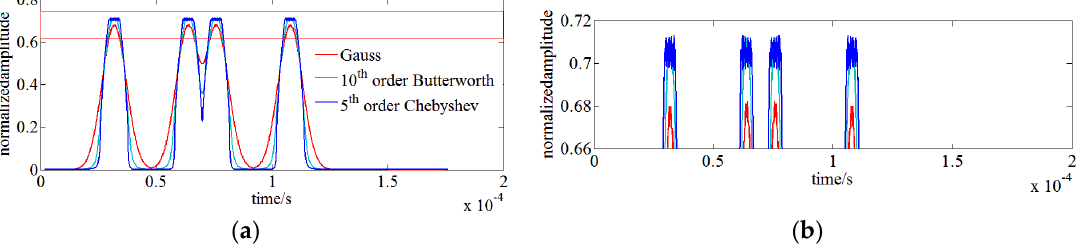
Figure 5. ( a ) Full view of the influence of RBW filters of different types on the spectral resolution; ( b ) Partial view of (a).